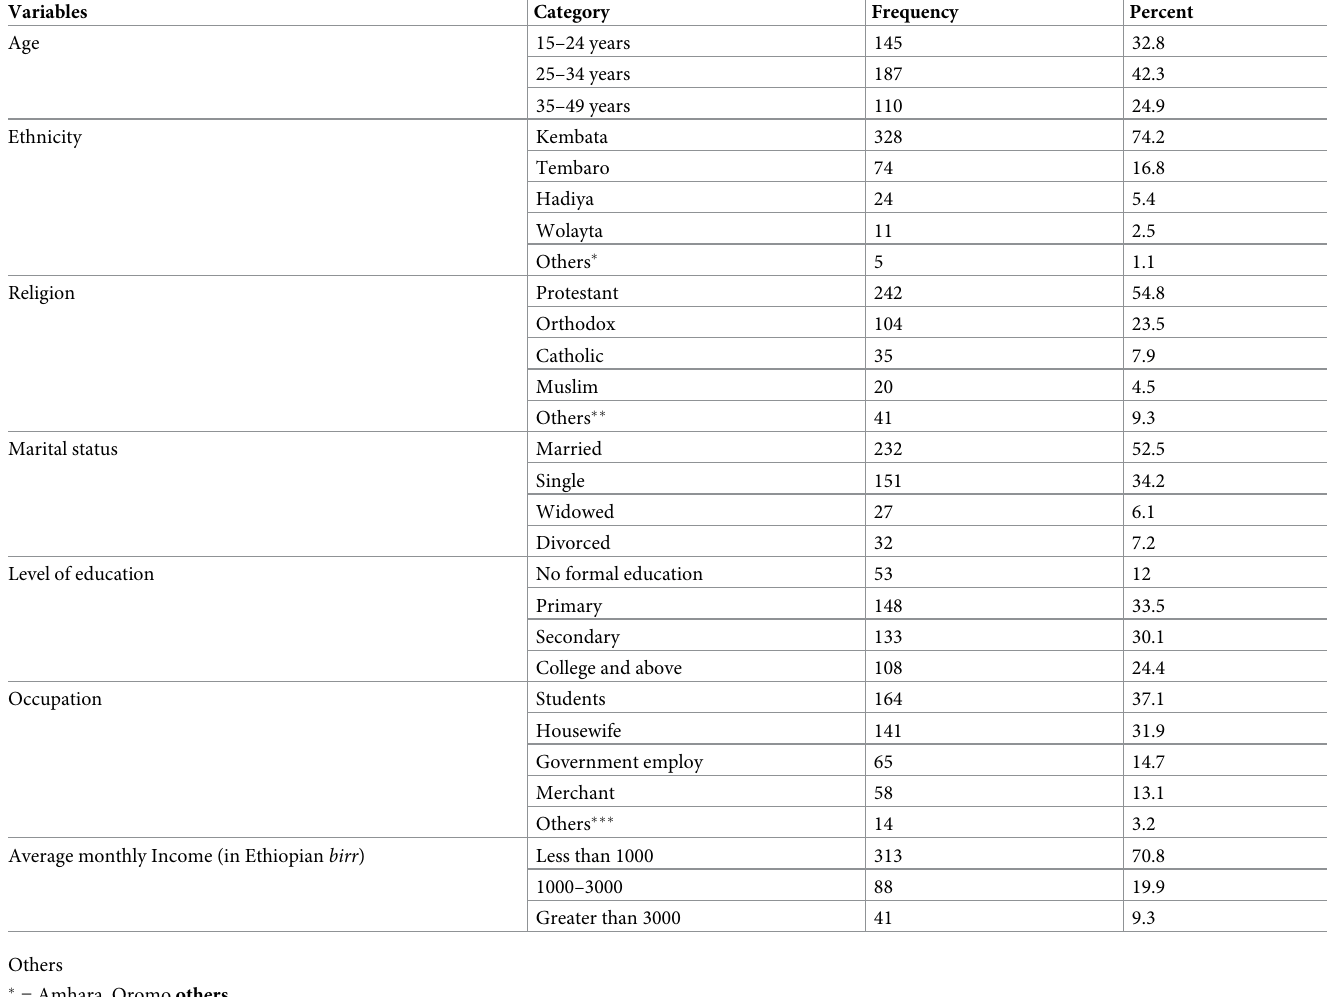
Table 1. Socio-demographic characteristics of females (15–49 years) in Durame town, SNNPR, Ethiopia, 2020 (n =